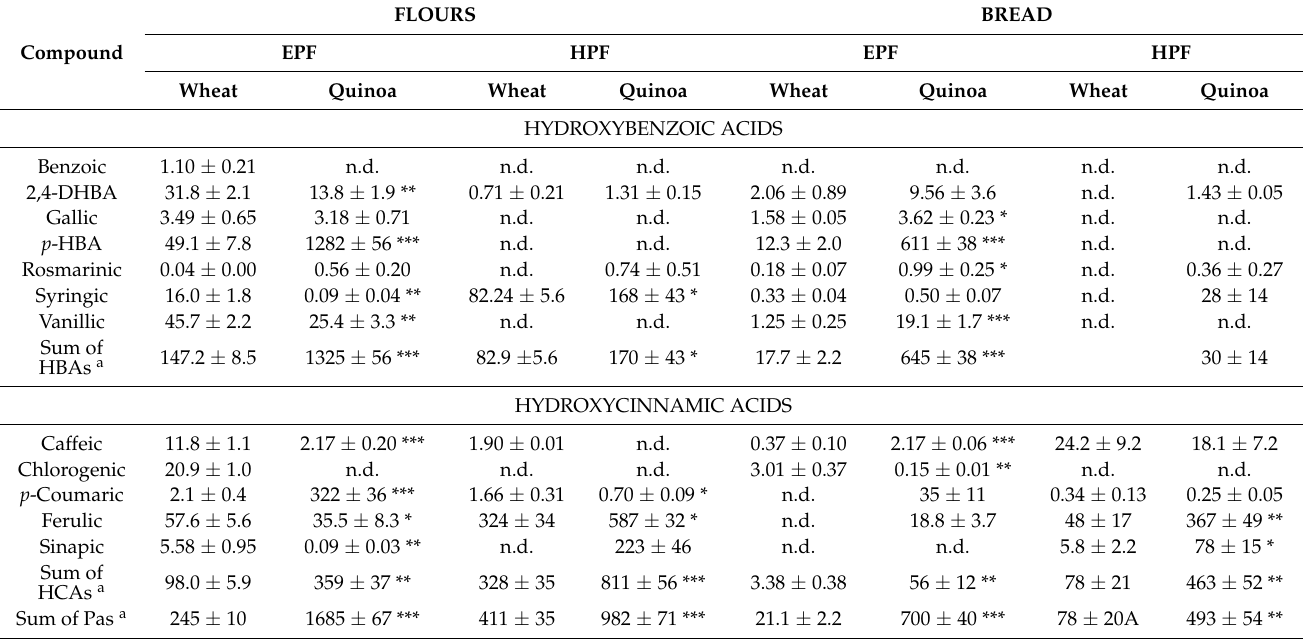
Table 2. Phenolic acids quantification ( µ g/g) in raw materials (wheat and quinoa flours) and bread (control and 25%